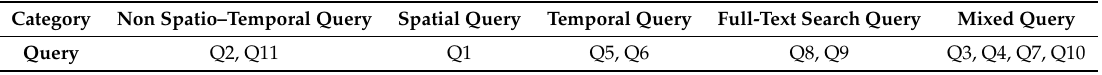
Table 6. Categorizing queries based on their